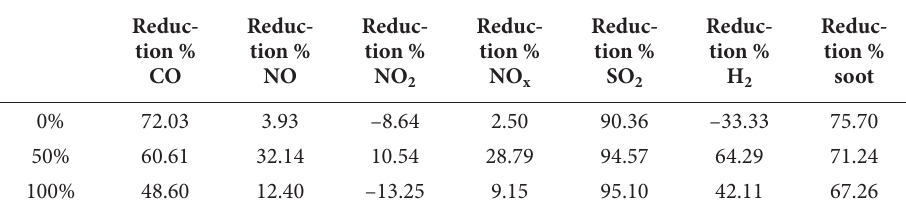
Table 5. Percent of reduction of pollutants using buses with biodiesel propulsion at various load levels (Žeželj et al . 2007)